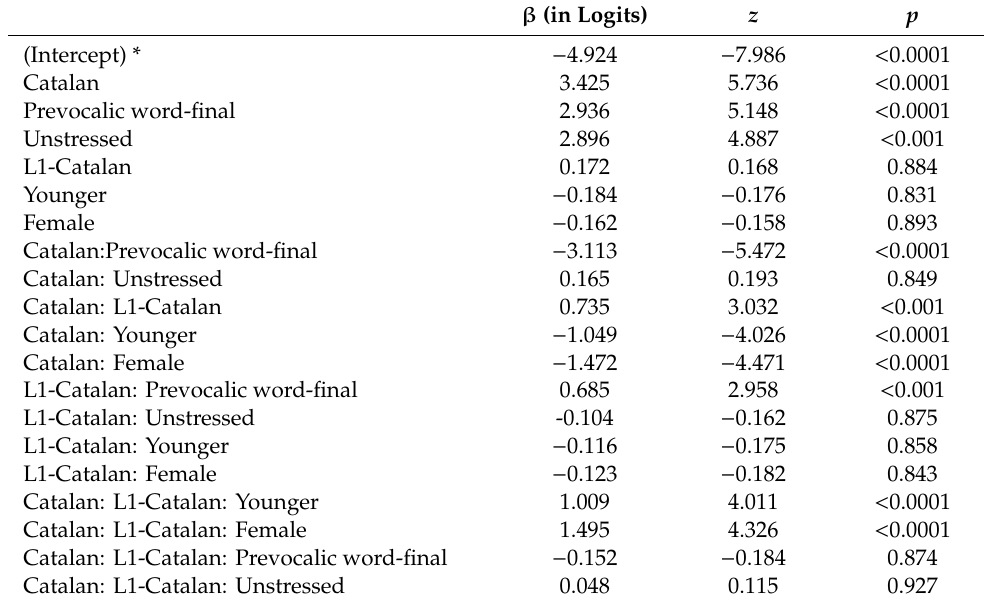
Table 3. Summary of the mixed-e ff ects logistic regression model fitted to Valencian